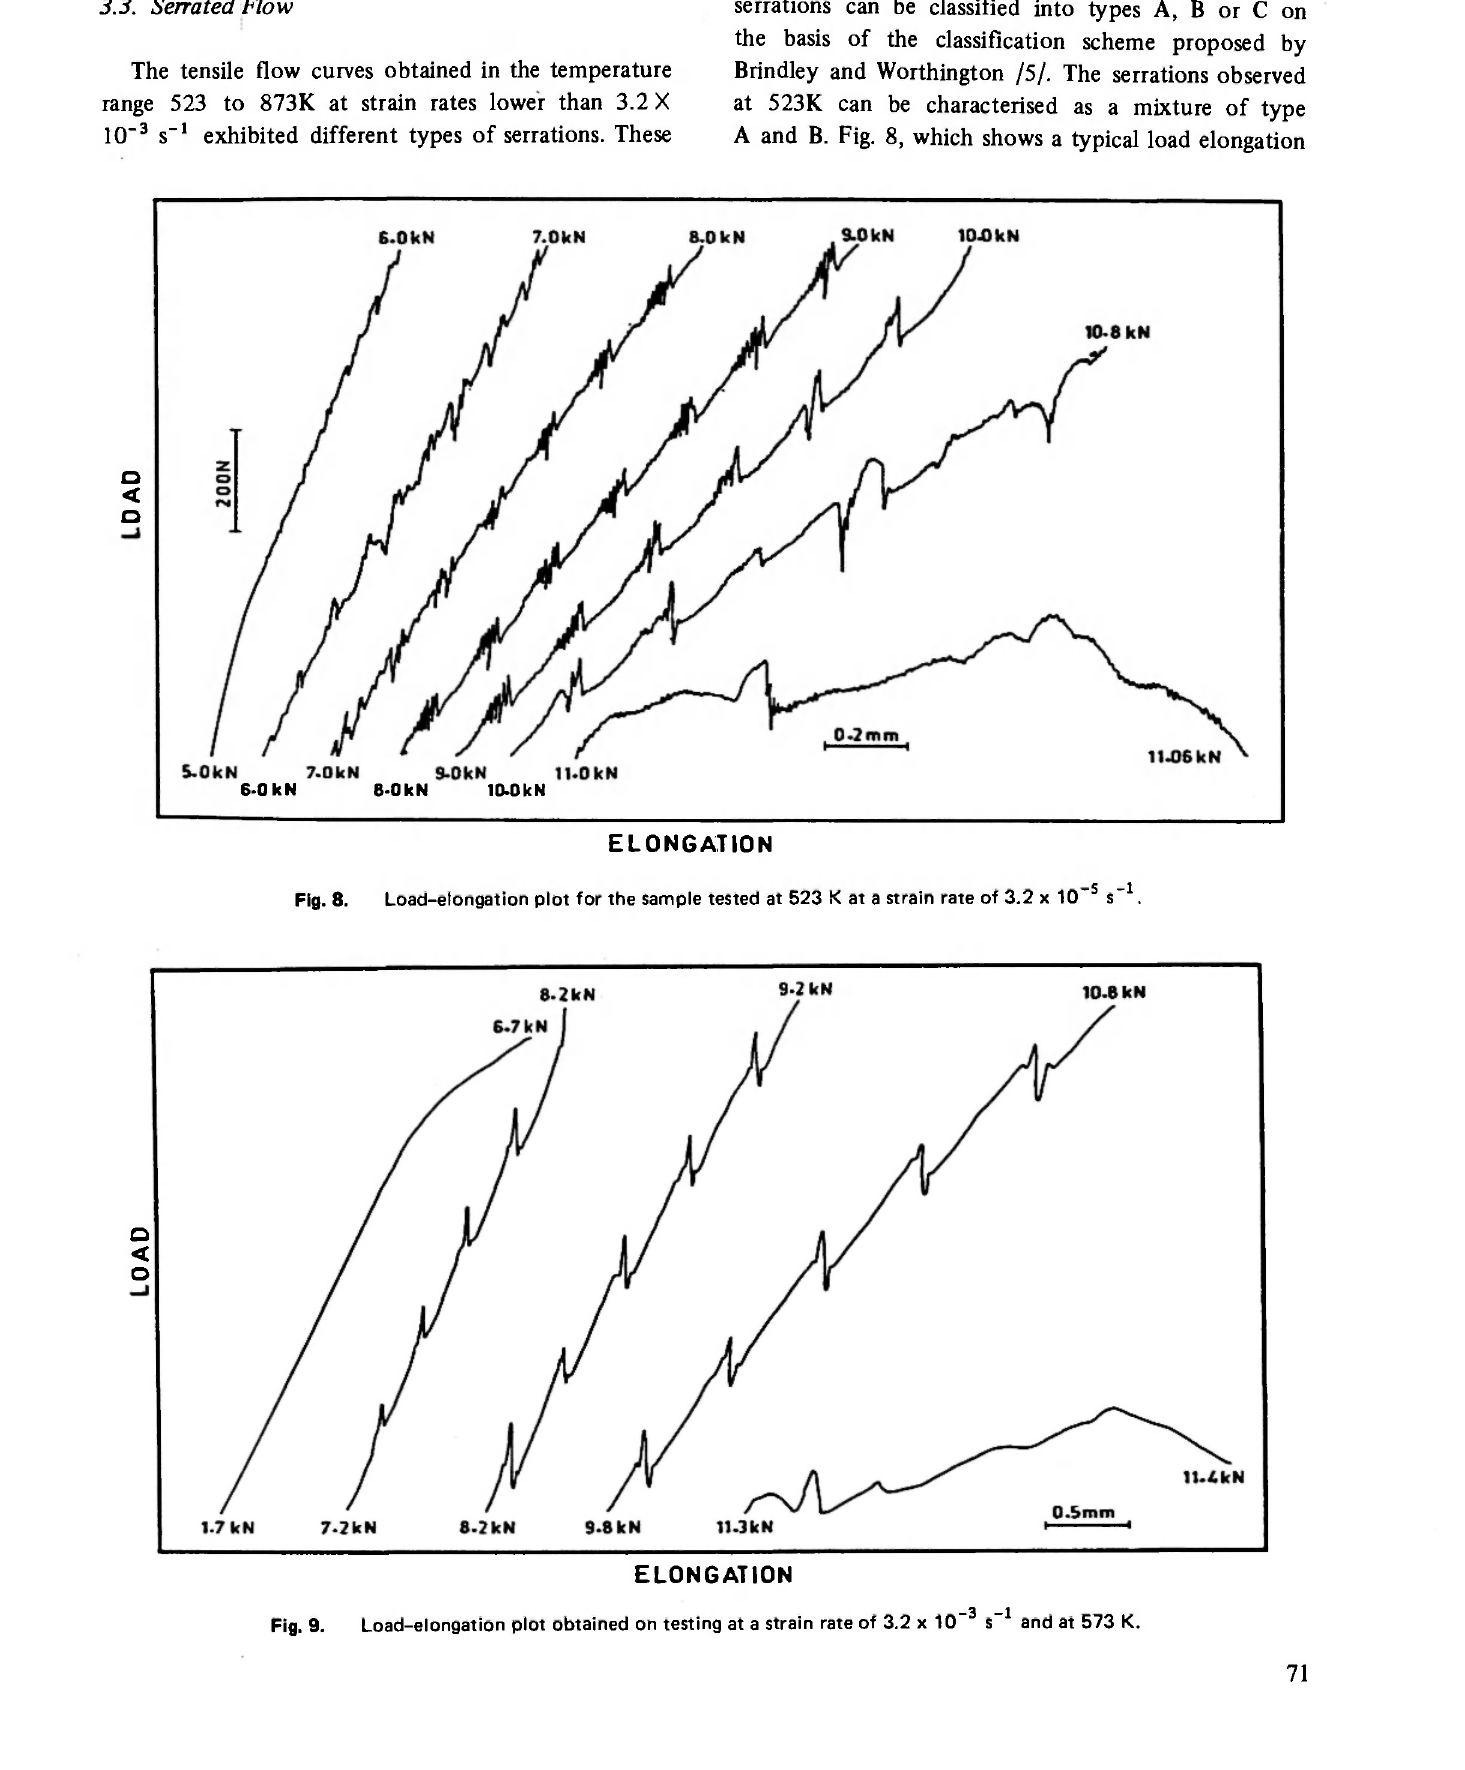
Fig. 9. Load-elongation plot obtained on testing at a strain rate of 3.2 χ 10 s and at 573